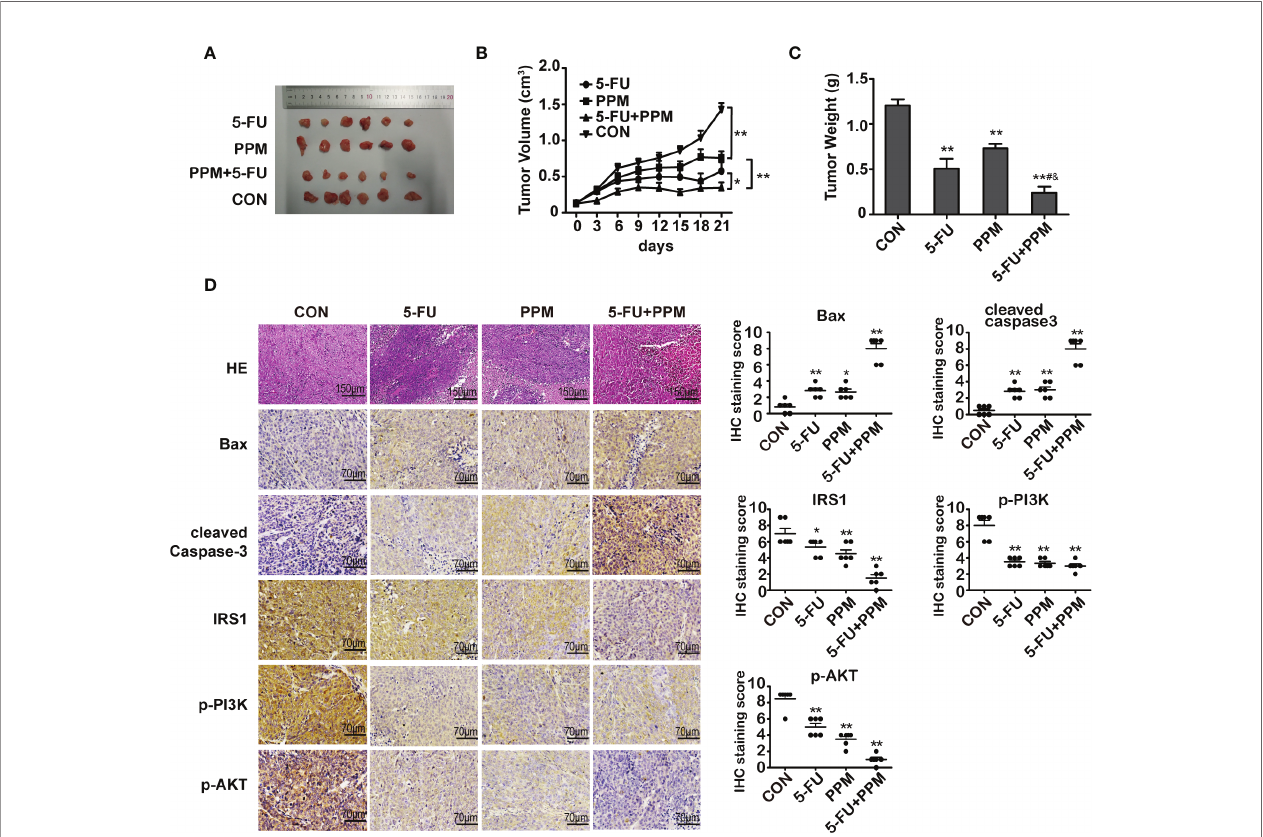
FIGURE 7 | The effect of periplocymarin (PPM) on colorectal cancer cells in nude mice. (A) Images of tumors derived from mice in each group. (B) Tumor volumes were calculated in each group every 3 days from days 1 to 21. (C) Tumor weights were measured on day 21. (D) Hematoxylin/eosin-stained sections of tumor tissues derived from mice in each treatment group were presented. Magni fi cation: 200×. Scale bar, 150 m m. The expression of Bax, cleaved caspase-3, IRS1, p-PI3K, and p-AKT in tumor tissues of mice from each treatment group was examined by immunohistochemistry. Magni fi cation: 400×. Scale bar, 70 m m. * P < 0.05, ** P < 0.01, vs . untreated control group. # P < 0.05, vs . 5-FU treatment group. & P < 0.05, vs . PPM treatment group. n =6 per